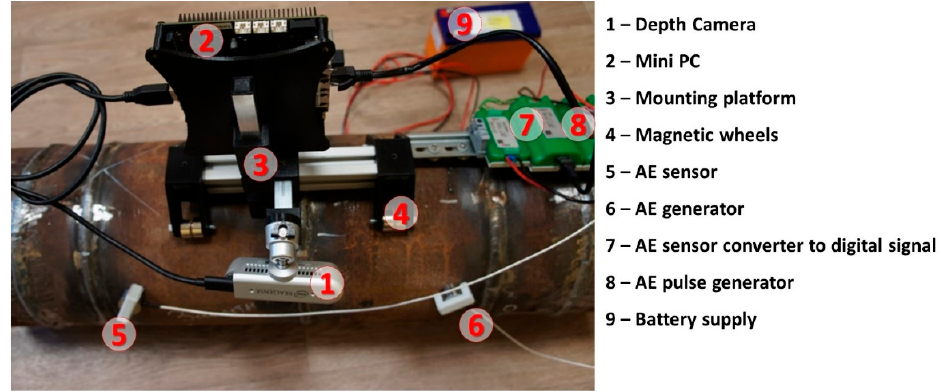
Figure 9. Experimental setup installed on the pipe.